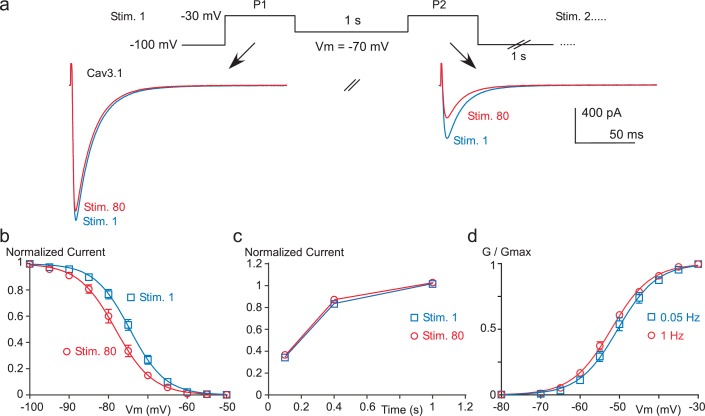
Paired-pulse stimulation at high frequency induces a negative shift in the Cav3.1 steady-state inactivation properties.(a–b) Steady-state inactivation of the Cav3.1 current measured using a paired-pulse stimulation (inter-stimulation 1 s) applied 80 times (Stim 1 to Stim 80). The membrane potential (Vm) between the two pulses ranged from −110 to −50 mV, as illustrated in (a) for a Vm of −70 mV. Steady-state inactivation (measured at P2) as a function of the Vm is determined for the first stimulation (Stim 1) and for the 80th stimulation (Stim 80, (b), n = 5–13 per point). (c) Recovery from short-term inactivation of the Cav3.1 current measured by a paired-pulse stimulation (inter-stimulation 1 s) applied 80 times (Stim 1 to Stim 80). The recovery from short-term inactivation, as a function of the interpulse duration (100, 400 or 1000 ms) is quantified for the first stimulation (Stim 1) and for the 80th stimulation (n = 8–9 per point). (d) Activation curve of the Cav3.1 current measured during 1 Hz or 0.05 Hz stimulation. The Cav3.1 current was stimulated at 1 Hz or 0.05 Hz until reaching the steady-state just before I-V protocols, which were performed by a double-pulse protocol to maintain the 1 Hz stimulation effect (n = 6).